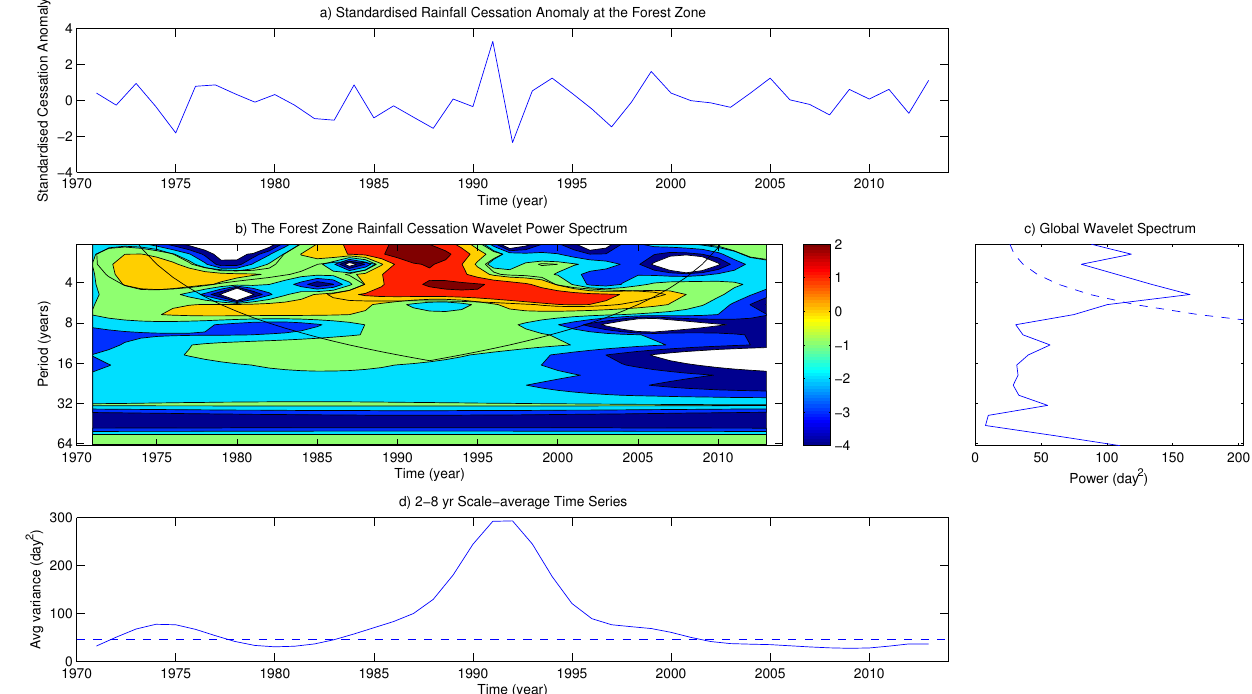
Figure 11. Interannual variability of rainfall cessation dates for the forest zone using wavelet analysis. ( a ) Standardized anomaly of cessation; ( b ) the same as in Figure 6, but for cessation; ( c ) the same as in Figure 6; ( d ) as in Figure 6; the dashed line shows the 95% confidence level.